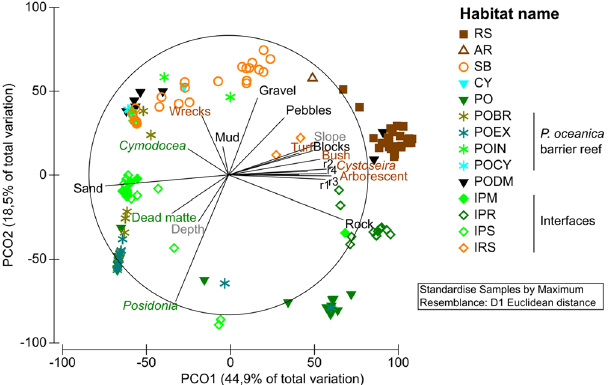
Figure 2. Principal coordinate analysis (PCoA) ordination plot of centroids of habitat descriptor assemblages according to habitat types. Correlation vectors (Spearman) of descriptors are plotted (correlations > 0.2). RS: Rocky substrates; AR: Artificial rocky reefs; SB: soft bottoms; CY: Cymodocea nodosa beds; PO: Posidonia oceanica beds; POBR: Posidonia barrier reef flat; POEX: Posidonia barrier reef outer slope; POIN: Posidonia barrier reef inner slope; POCY: Barrier reef lagoon with Cymodocea ; PODM: Posidonia dead matte; IPR: Interface Posidonia /Rocky substrates; IPS: Interface Posidonia /Soft bottoms; IPM: Interface Posidonia /Dead matte; IRS: Interface Rocky substrates/Soft